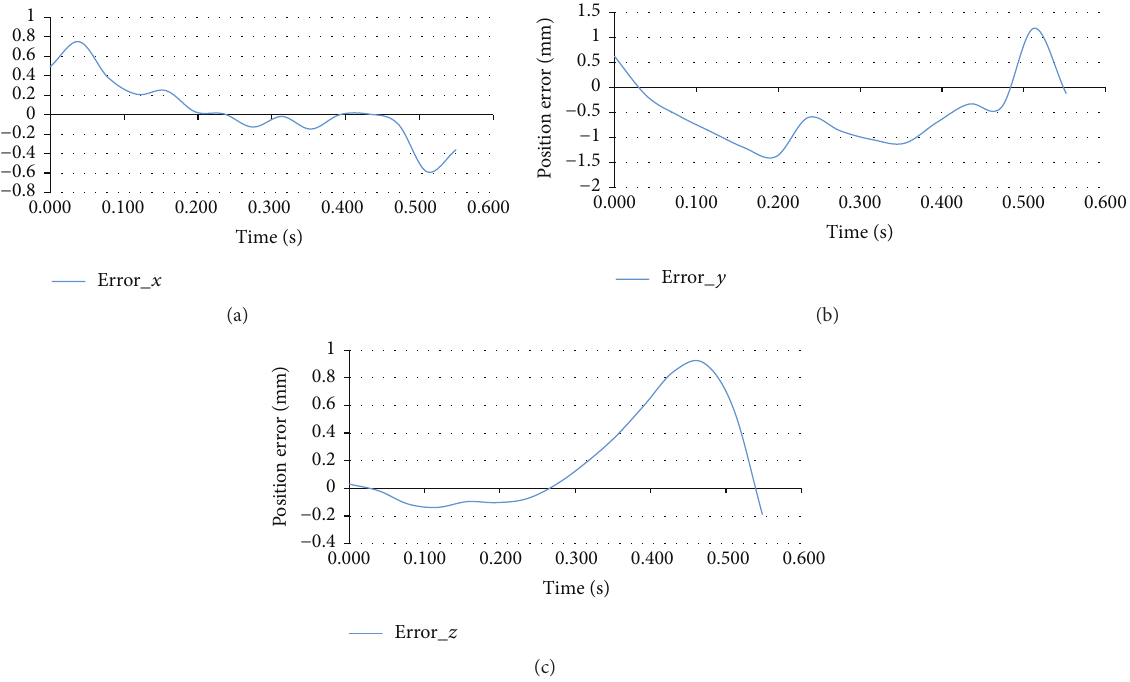
Figure 9: (a) Position error of end effector in 𝑥 -axis, (b) position error of end effector in 𝑦 -axis, and (c) position error of end effector in 𝑧